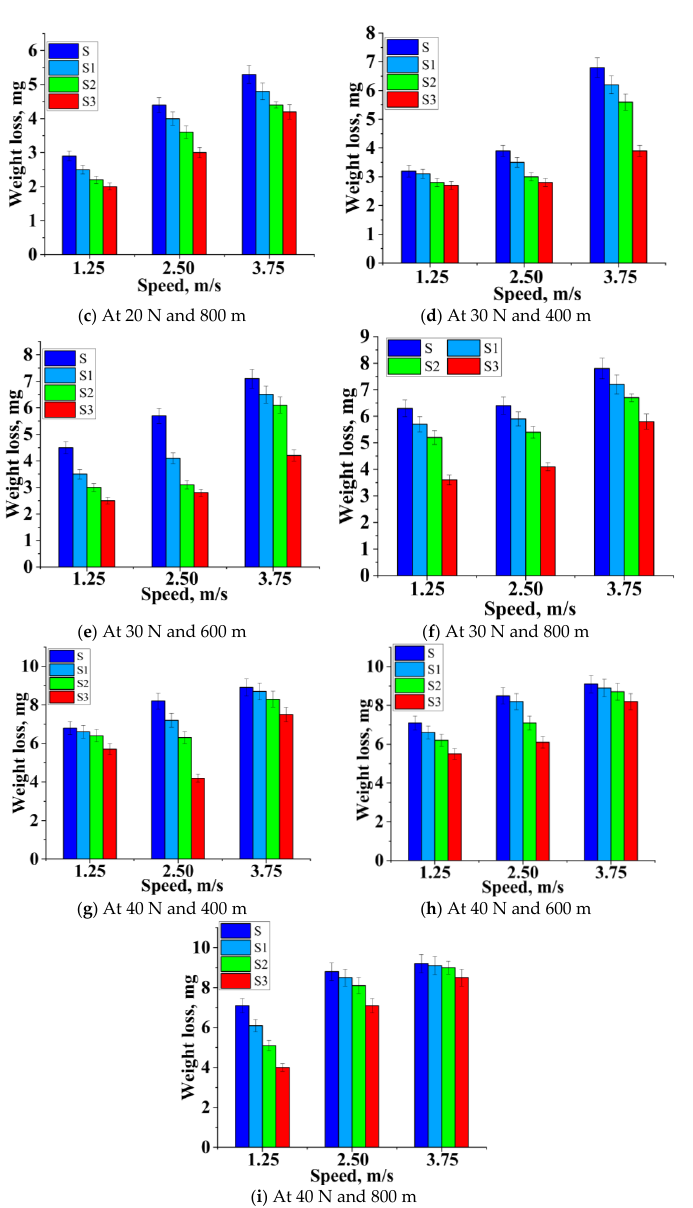
Figure 5. Effect of sliding velocity vs. weight loss at different load and distance ( a – i ).